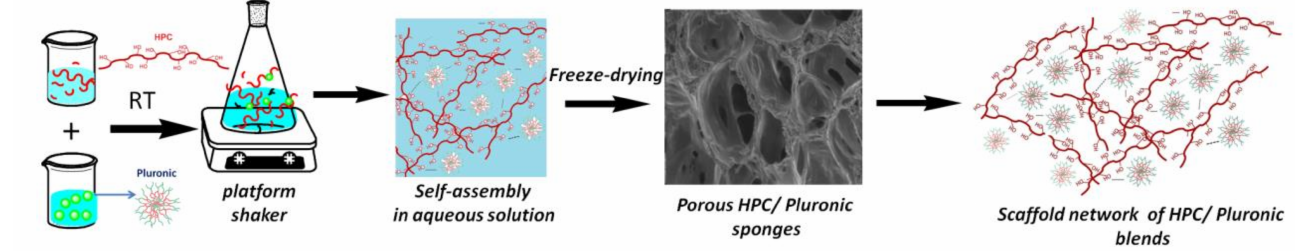
Figure 14. Schematic representation of the preparation of porous scaffold networks (sponges) based on HPC and Pluronic F68 blends. Hydrogen bonds are highlighted withdashed lines in the represen- tations of the scaffold networks of HPC/Pluronic